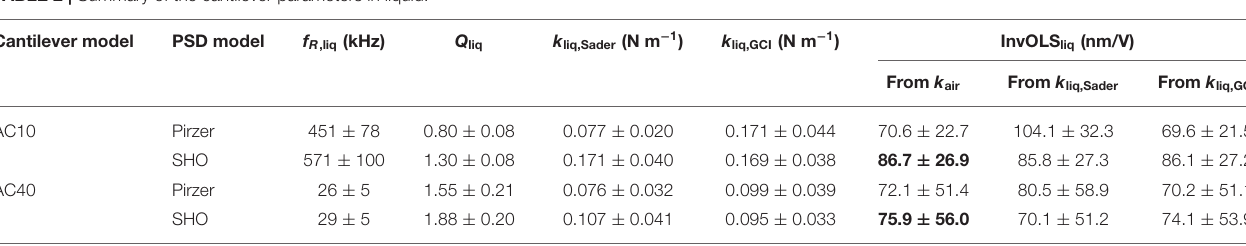
TABLE 2 | Summary of the cantilever parameters in